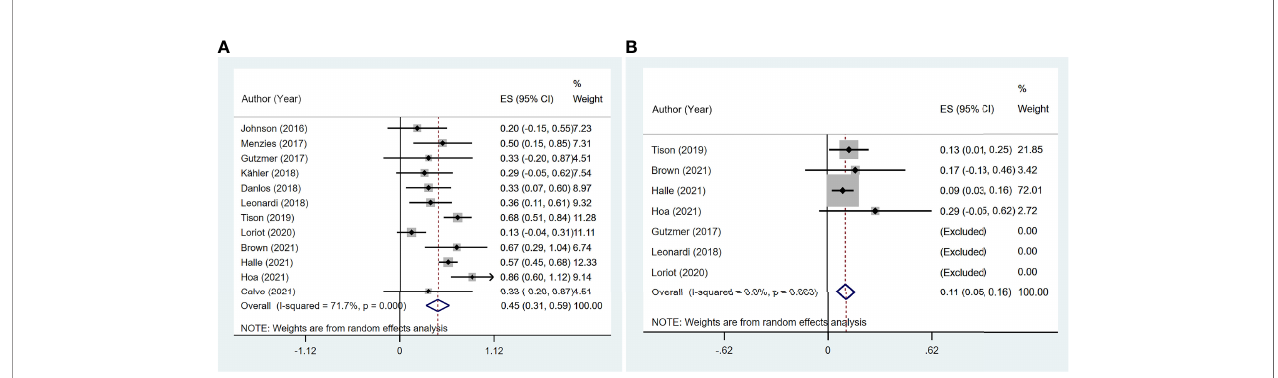
FIGURE 2 | The pooled incidence of fl are in patients with cancer and preexisting psoriasis. (A) The incidence of fl are for any grades. (B) The incidence of fl are for grades 3